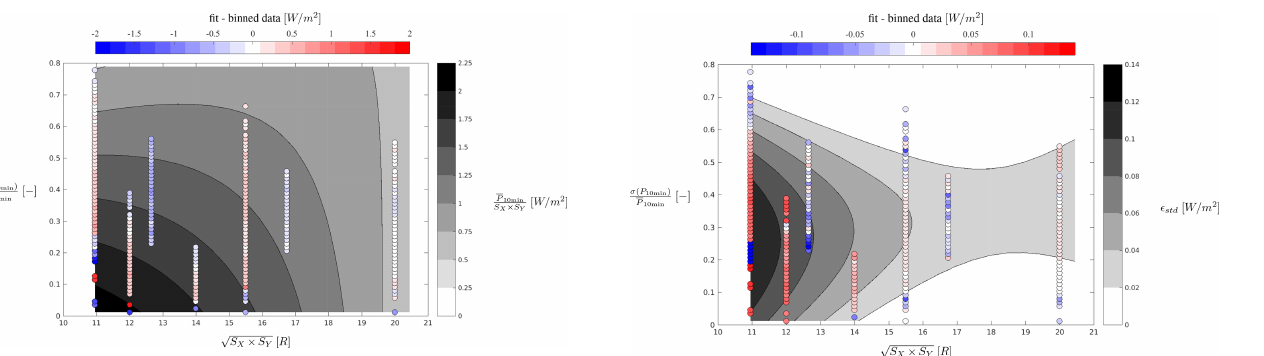
Figure 11. Contours based on multiple linear regression fit of the standard error in the bin-averaged power production per area to the standard deviation of power production normalized by mean power production and relative turbine spacing. Points mark the binned data, where blue and red shades indicate whether the fit underes- timates or overestimates, respectively, the binned averaged